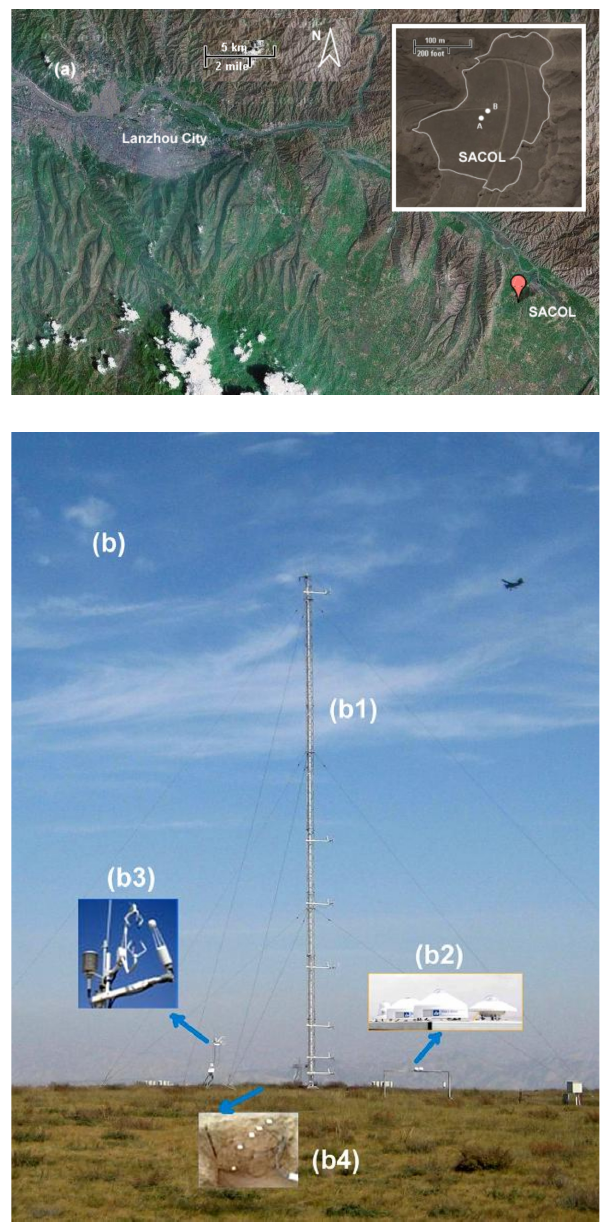
Fig. 1. (a) Topographic map of Lanzhou city, indicating the location of the SACOL site, and with an enlarged image of the site. (b) The SACOL field site, showing vegetation, with boundary layer mete- orological tower (1b1), surface radiation monitoring (1b2), eddy- covariance system (1b3) and soil monitoring system (1b4).